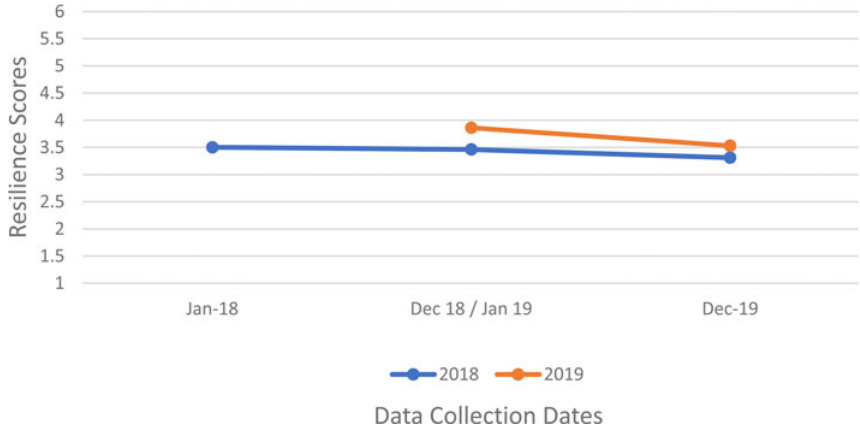
Fig. 1. Resilience Mean Scores for 2018 & 2019 Cohorts